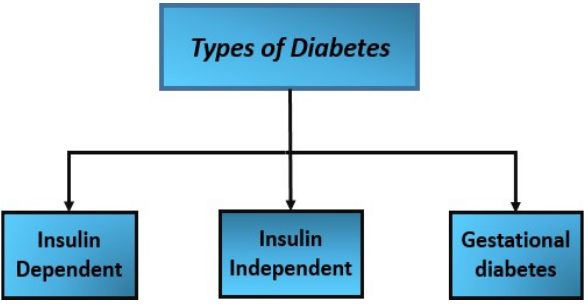
Figure 1. Diabetes types.